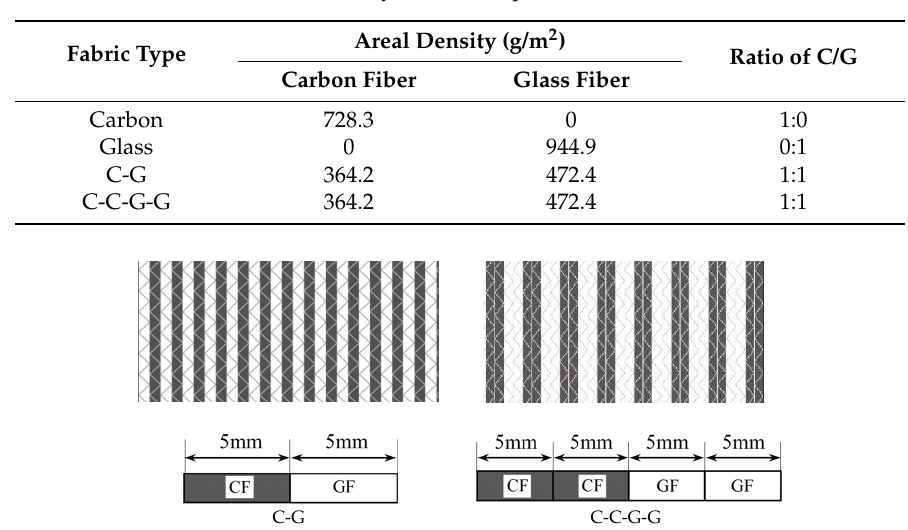
Figure 1. Schematic structure of two interlayer hybrid fabrics (C:G = 1:1).